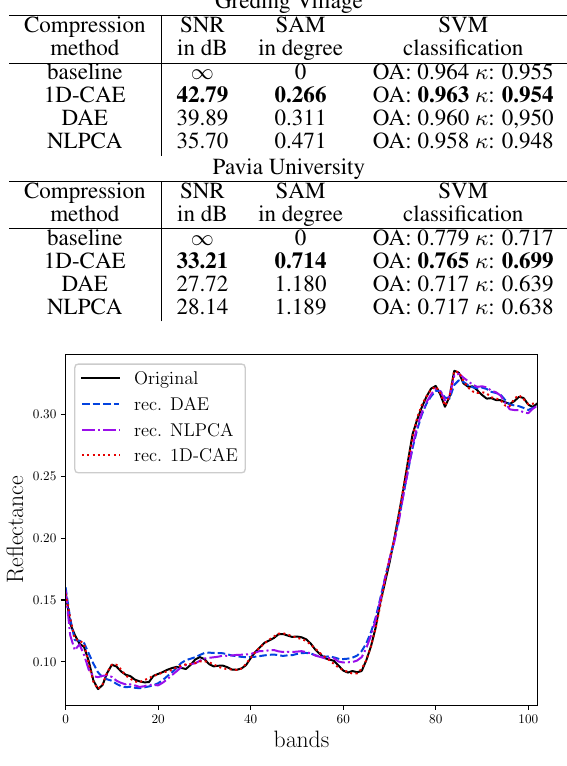
Figure 2. Comparison of the original spectrum of vegetation with the reconstructions of the 1D-CAE, DAE and